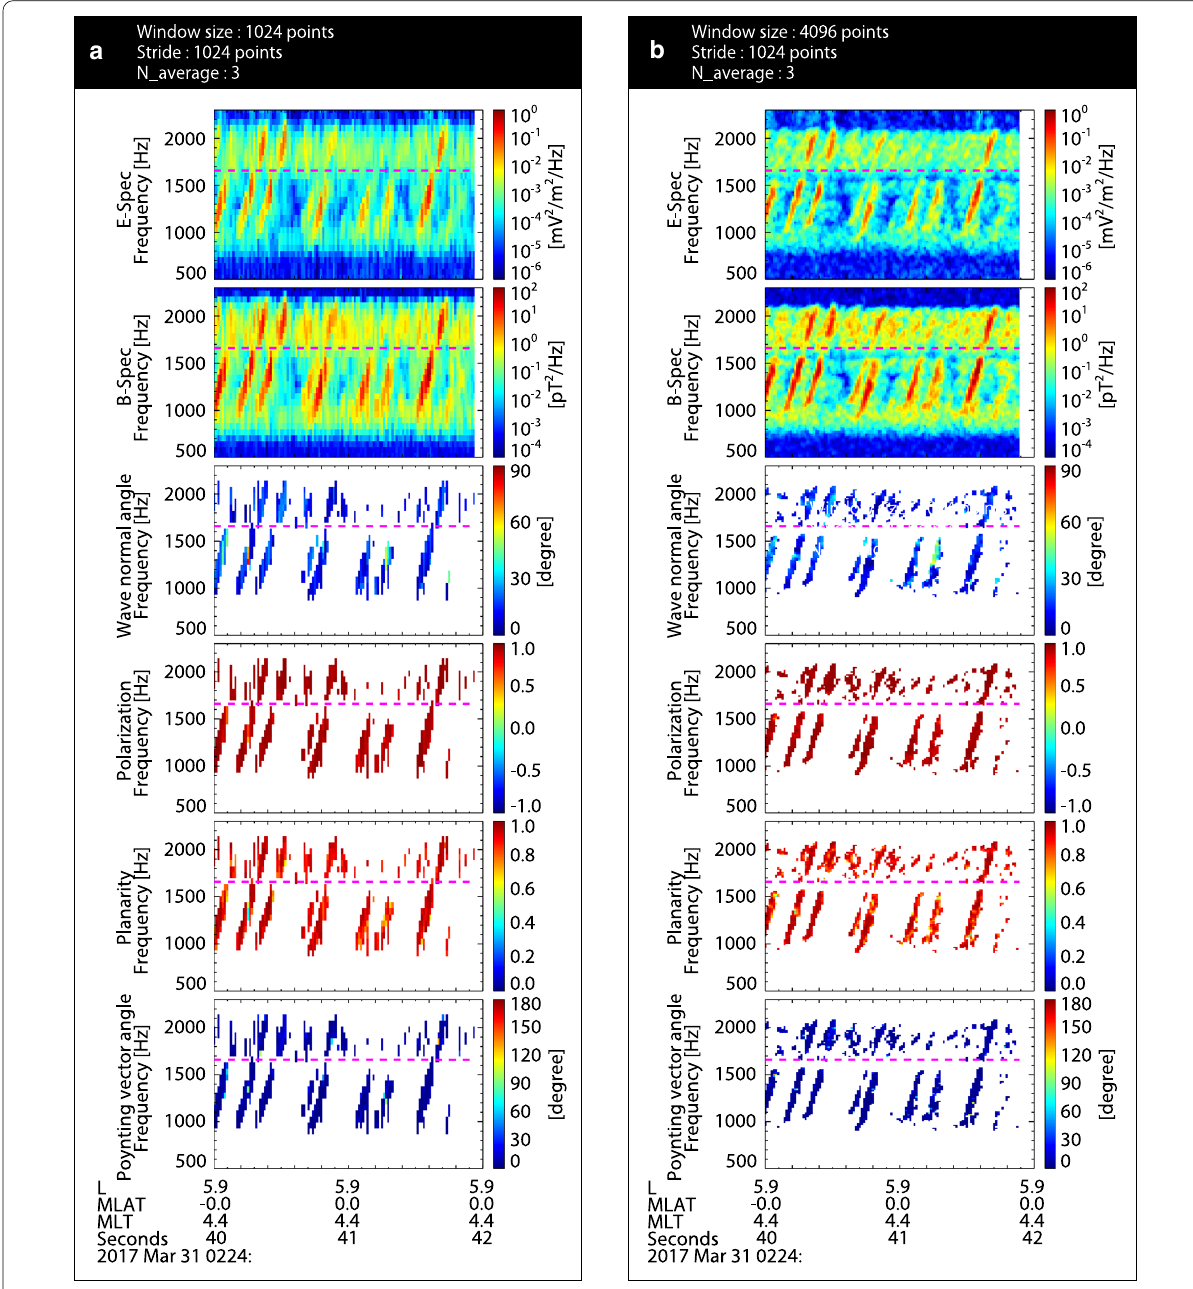
Fig. 5 Examples of results for different FFT window sizes; a 1024 points, b 4096